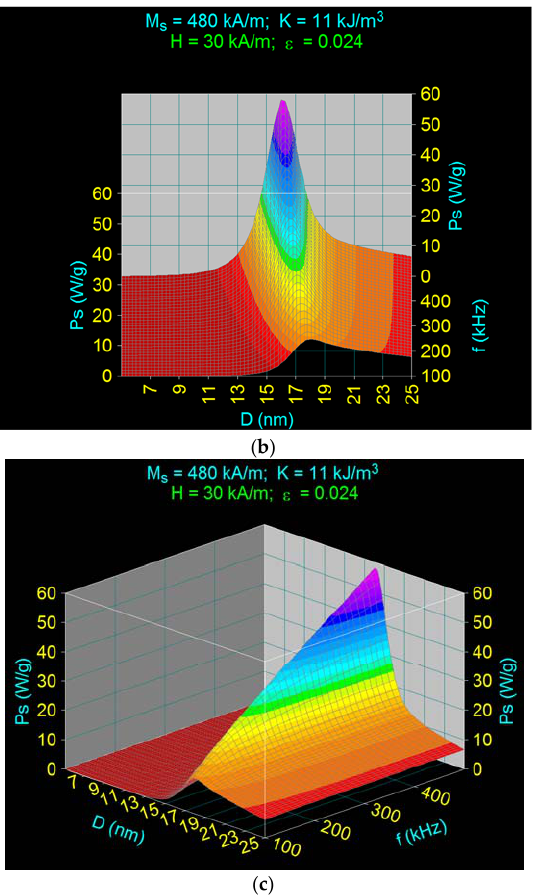
Figure 6. The contribution of the Néel and Brown relaxation processes to the maximum specific loss power in the case of dispersed bionanoparticles of Fe 3 O 4 – γ -CDs for the diagrams at ( a ) D < D M , ( b ) front, ( c ) D > D M .